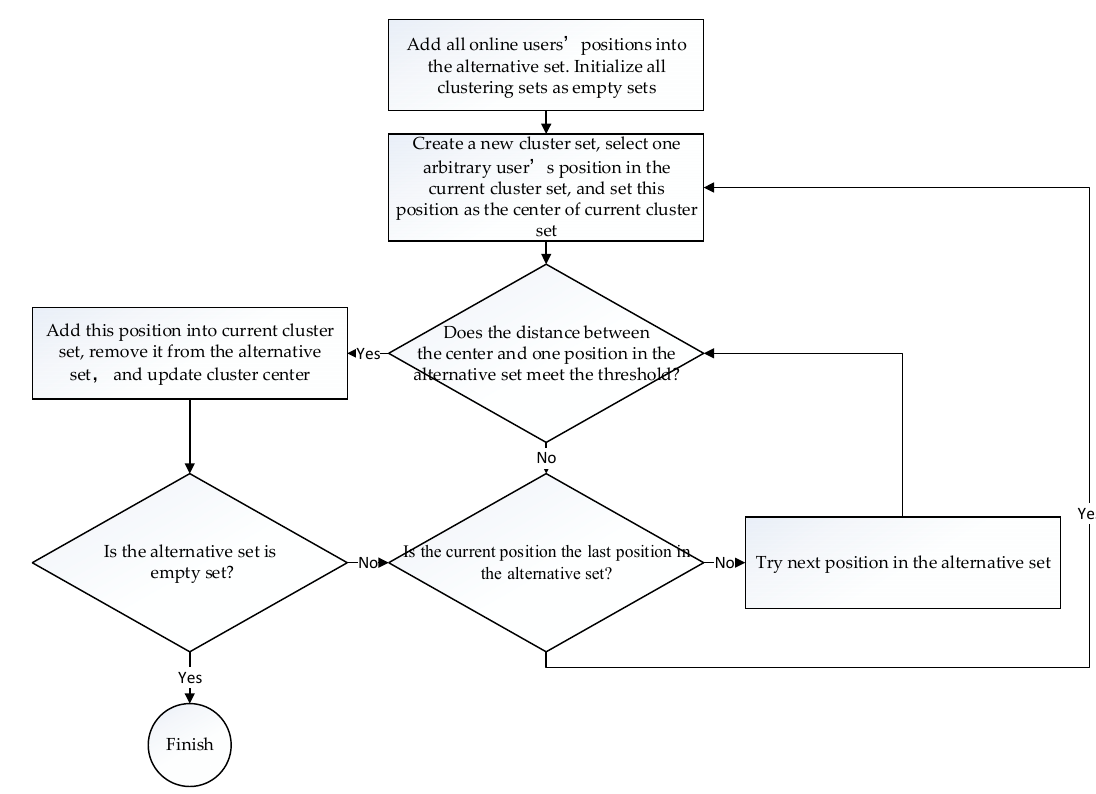
Figure 4. The flowchart of the self-organizing spatial clustering algorithm.